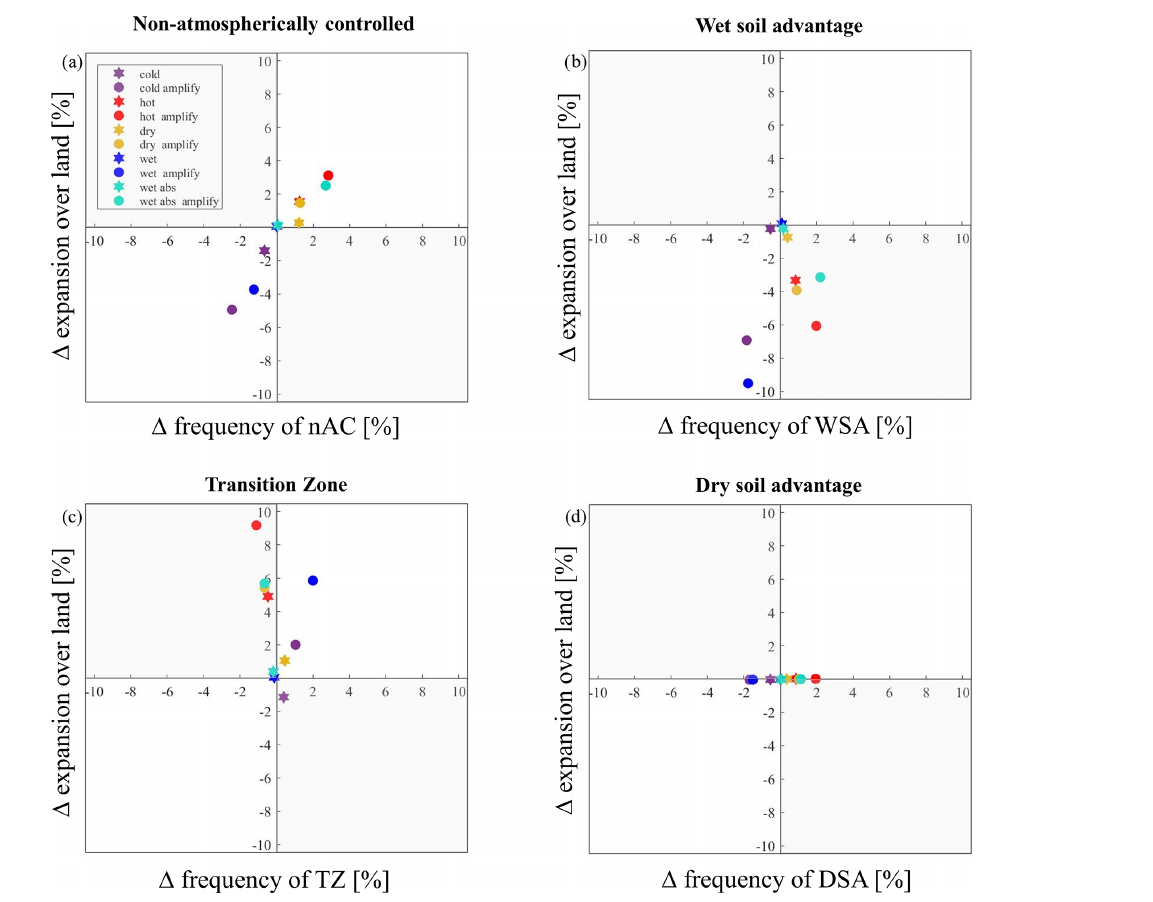
Figure 11. Impacts of the divergence cases on the spatial expansion and the occurrence of the coupling classes in summer for (a) non- atmospherically controlled (nAC) days, (b) wet soil advantage (WSA), (c) transition zone (TZ) and (d) dry soil advantage (DSA). The x axis depicts the changes in the average frequency of occurrence during summer and the y axis shows changes in the fraction of land area covered by the respective coupling